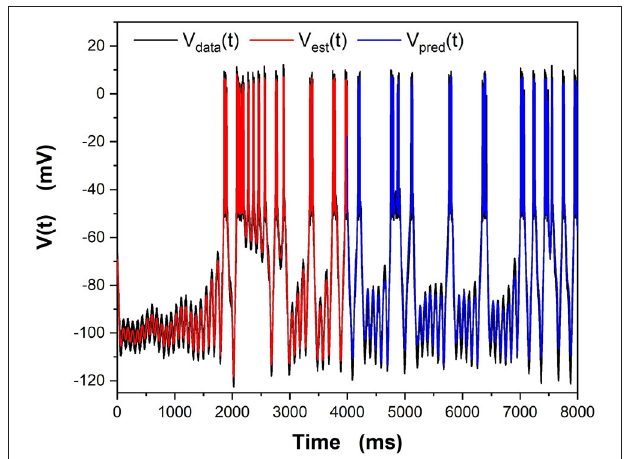
FIGURE 5 | Results of the “twin experiment” using the model HVC X neuron described in the Supplementary Data Sheet 1 . Noise was added to data developed by solving the dynamical equations. The noisy V ( t ) was presented to the precision annealing SDA calculation along with the I injected ( t ) in the observation window t 0 0ms, t F 4000ms. The noisy model voltage data is = = shown in black, and the estimated voltage is shown in red. For t 4,000ms ≥ we show the predicted membrane voltage, in blue, generated by solving the HVC X model equations using the parameters estimated during SDA within the observation